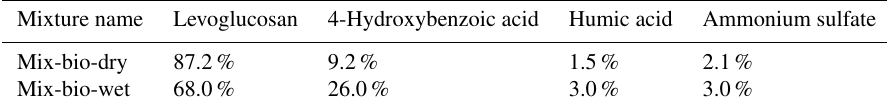
Table 2. The chemical composition of biomass-burning model mixtures studied given as mass percentages (wt%). See Sect. 3.3 for more information.